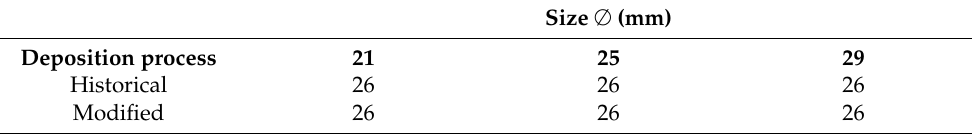
Table 1. Number of specimens of mechanical heart valve (MHV) orifices obtained through the two deposition processes.